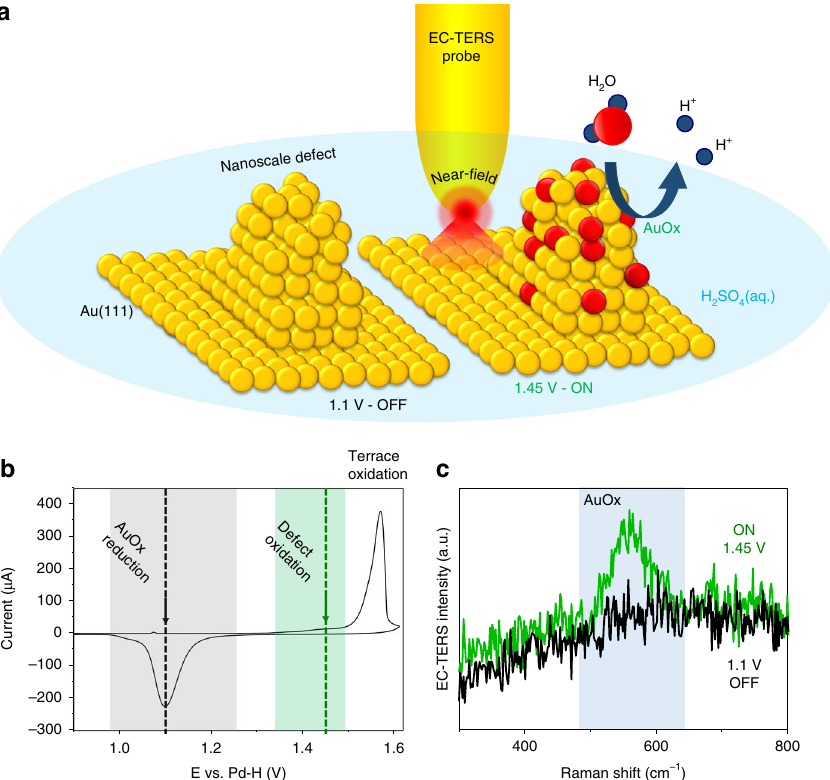
Fig. 1 EC-TERS of selective and reversible Au nanodefect oxidation. a Schematic of the EC-TERS operando nanoscopy approach: Defect oxidation OFF (left, 1.1 V vs. Pd-H) or ON (1.45 V vs. Pd-H) states can be spatially and chemically resolved by mapping the active site of interest with the EC-TERS probe with 9.4 nm spatial precision during electro-activation. b Cyclic voltammogram of Au(111) in 0.1 M H 2 SO 4 recorded in the EC-TERS sample cell (scan rate: 50 mV s − 1 ). Green and gray areas highlight the defect oxidation and gold oxide (AuOx) reduction regions, respectively. c EC-TER spectra for ON (with AuOx peak at ca. 580 cm − 1 ) and OFF states recorded at the active (defect) site.